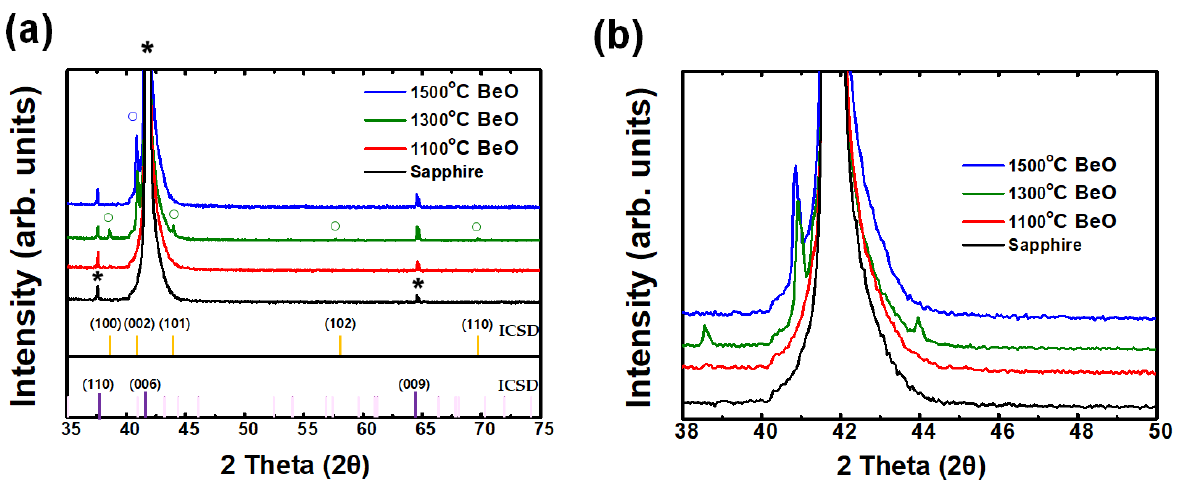
Figure 5. X-ray diffraction (XRD) peaks at a CA/BeSO 4 ratio of 1:1 of BeO thin films depending on the sintering temperature. The XRD peaks corresponding to BeO and sapphire are correspondingly denoted with the circle and star symbols and the crystal planes presented in yellow and purple. The bar graphs in yellow and purple are citied the XRD peaks of BeO and sapphire by the inorganic crystal structure database (ICSD) respectively.